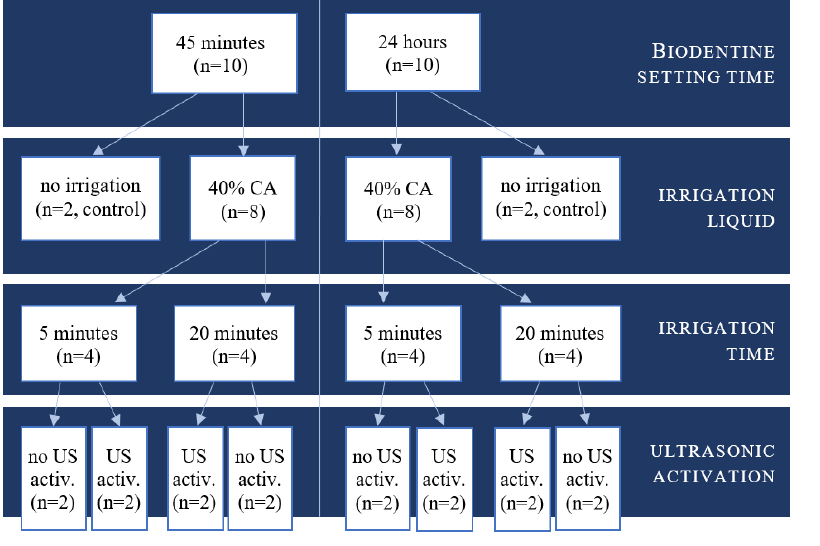
Figure 2. Schematic presentation of Biodentine samples’ distribution.